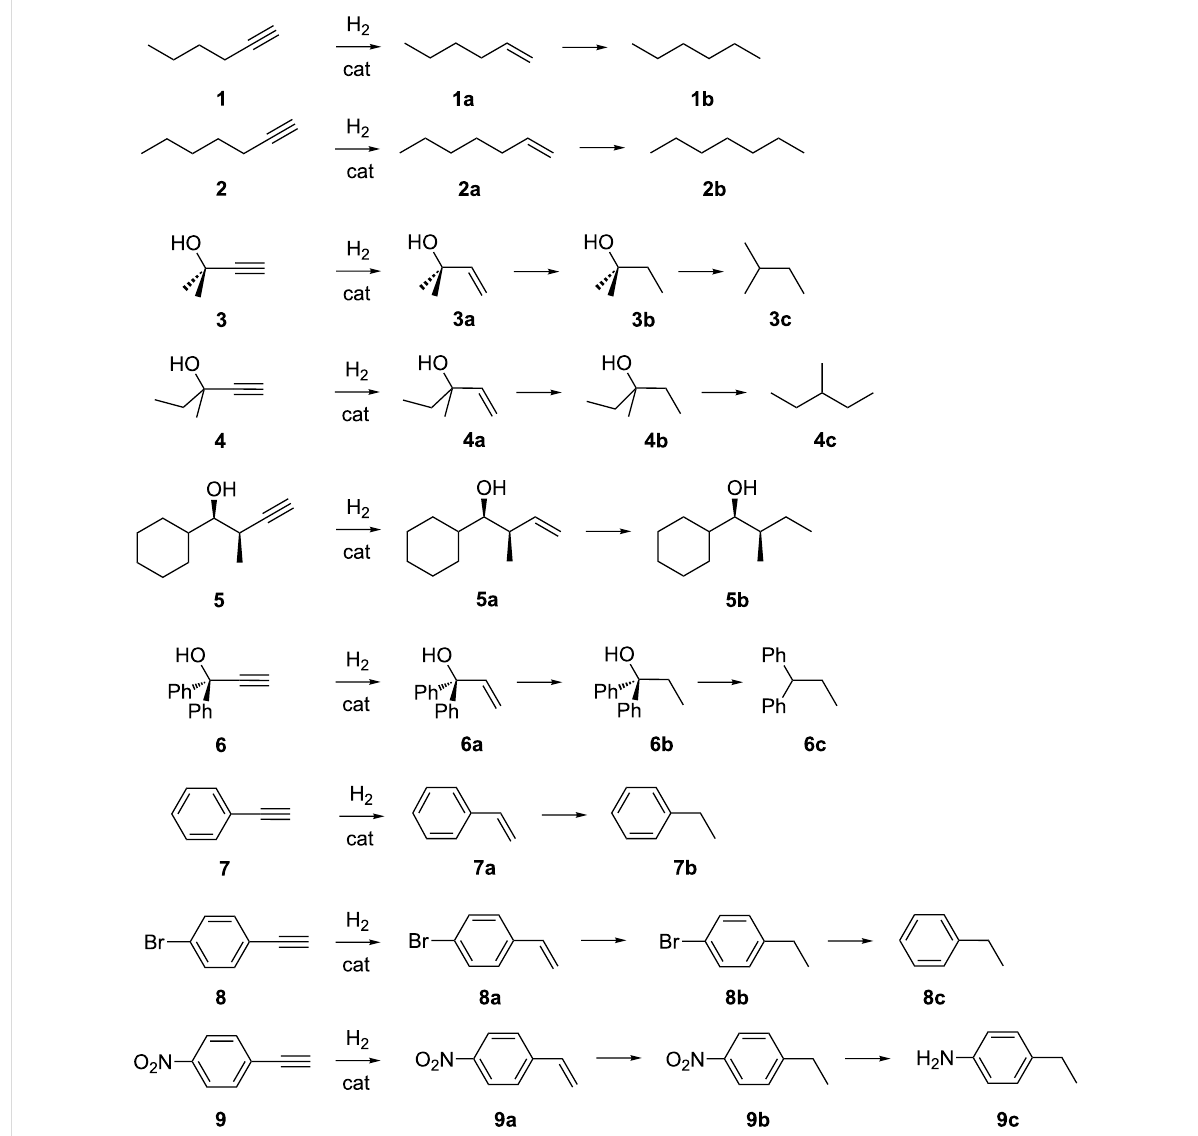
Scheme 2: Hydrogenation reactions of terminal alkynes with potential products and labelling